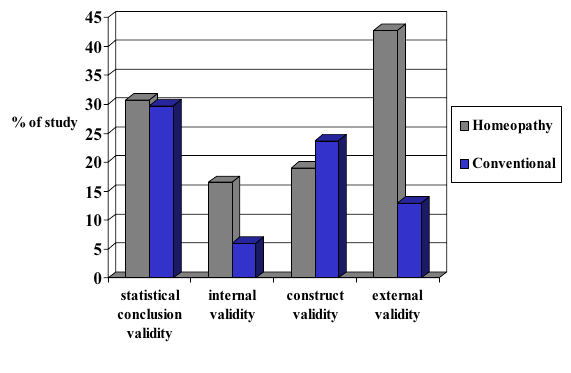
Figure 1 Average % of studies Not Meeting